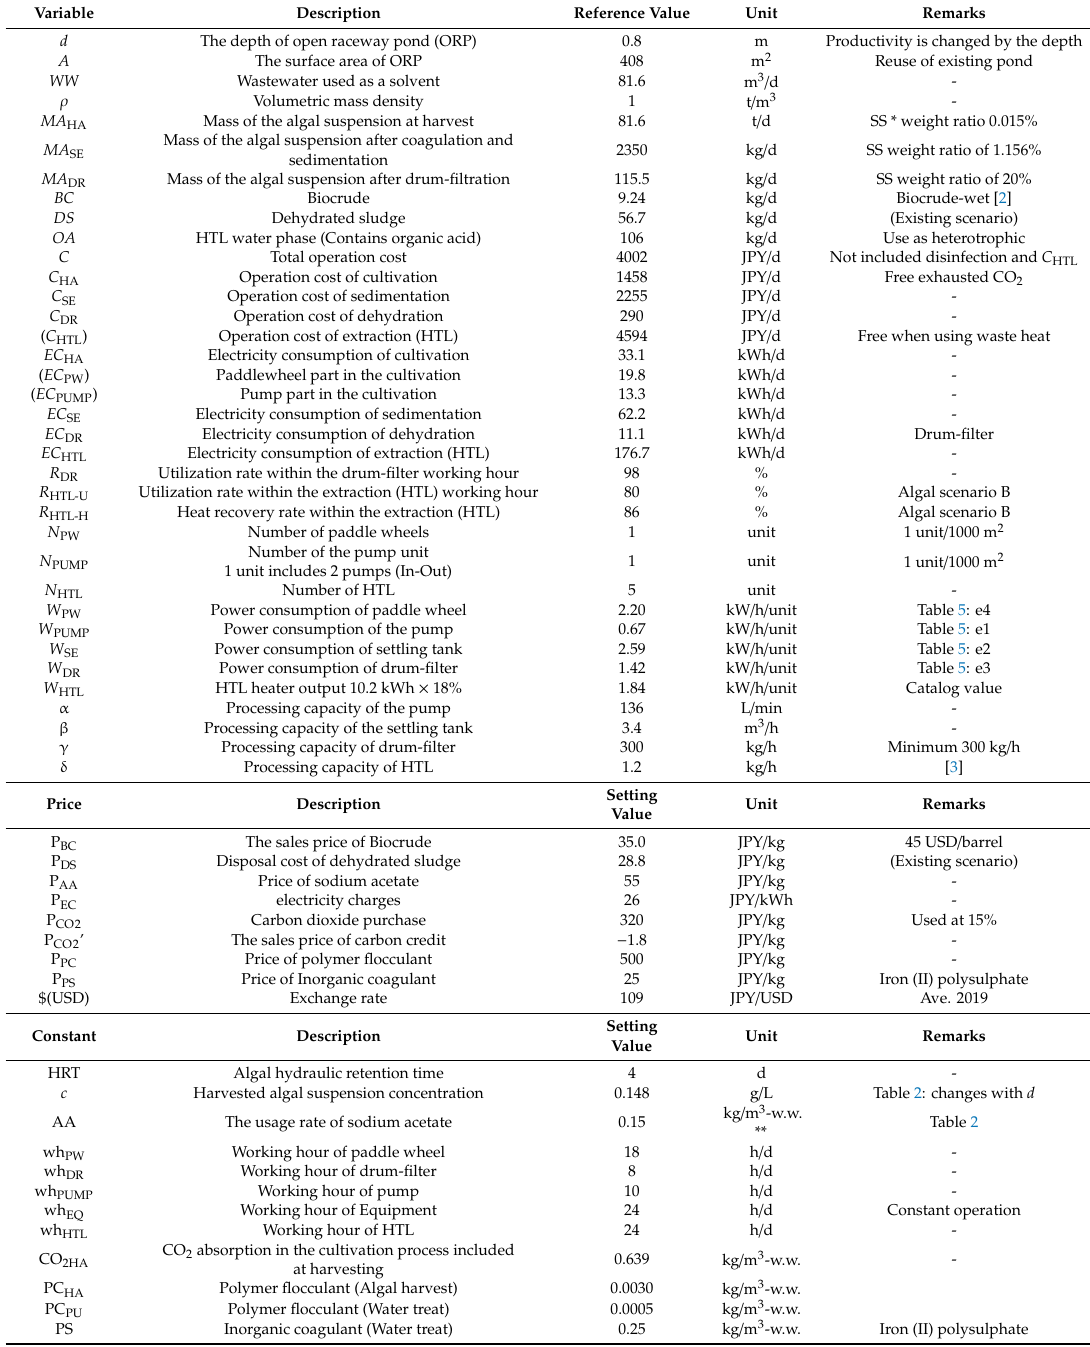
Table 4. Variables and constant values in microalgae oil production, for the treated volume of 81.6 m 3 -w.w. / d.